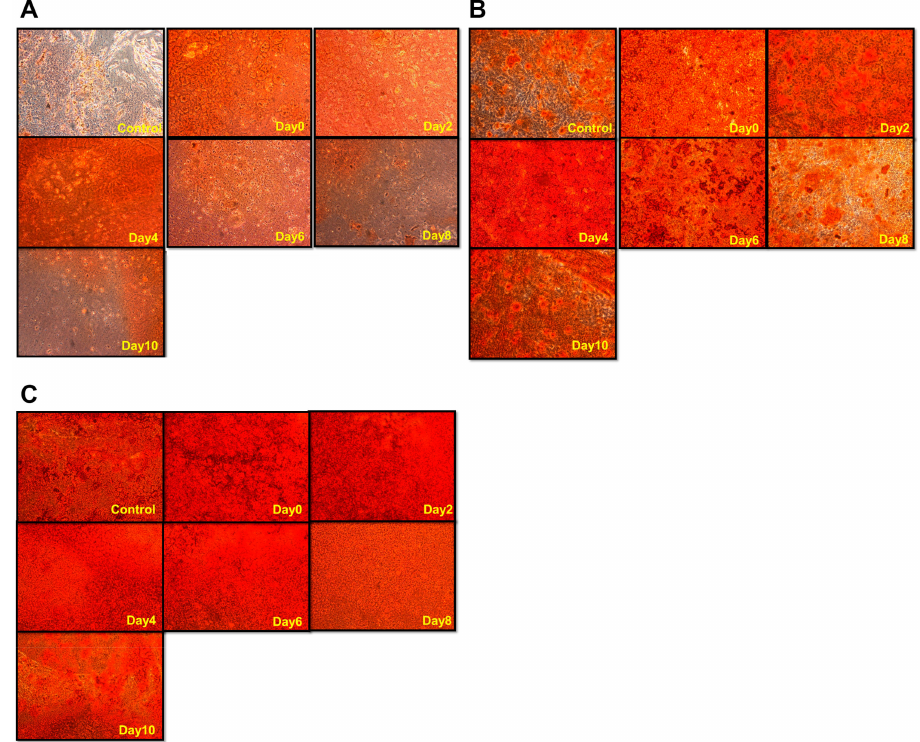
Figure 4. The levels and distributions of mineralization of hDPSCs treated with direct-current electric field (DCEF) on di ff erent days during osteo-di ff erentiation. After the induction of osteogenic medium, hDPSCs were stimulated by DCEF on di ff erent days (indicated by yellow words at the bottom-right corner of each image). Alizarin red S staining was performed on ( A ) day 12, ( B ) day 14, and ( C ) day 21 after osteo-induction to visualize the mineralization